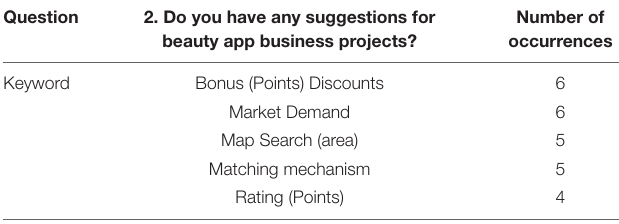
TABLE 5 | Interview results III. Question 3. How do you think the training should respond to the market demand for functional training or functional self-improvement in the beauty industry?